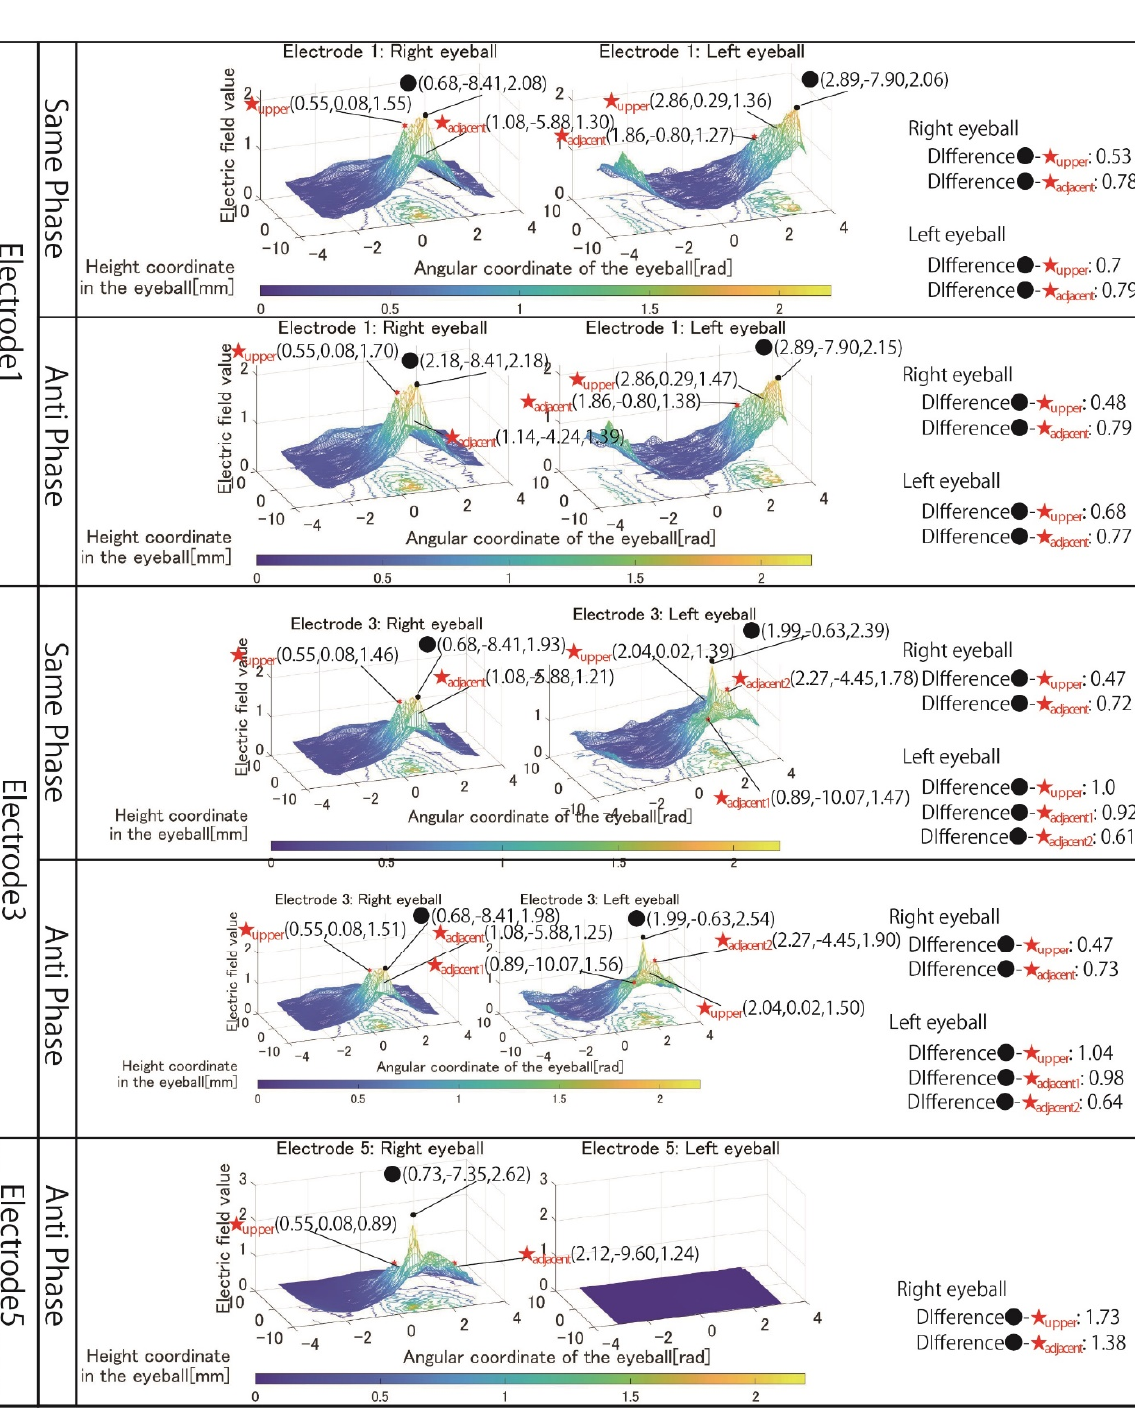
Figure 12. Simulation result with revised electrode arrangement to stimulate temporal right eye- ball.